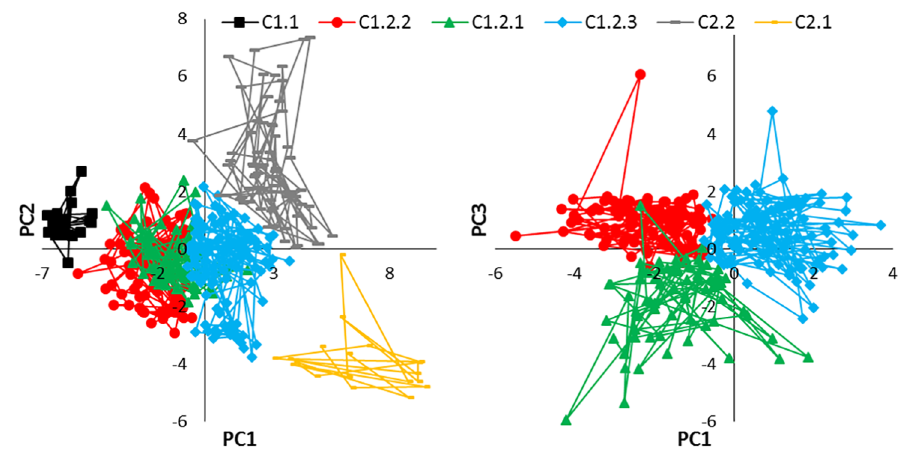
Fig. 5. On principal components planes constructed by PC1–PC2 and PC1–PC3 (and others not presented here), the cloud of the analysed samples grouped into clusters (C1.1, C1.2.1, etc.) demonstrates the correlation between samples and principal components. Note the different positioning of clusters on different planes, showing which component (and elements forming the corresponding component) best describe the samples in the cluster. On the plane PC1 (S, OM, trace metals) – PC2 (‘clay components’) clusters C1.2.1 (P 2 O 5 with SiO 2 , typical for the layers A and B1), C1.2.2 (Sr with CaO) and C1.2.3 (nearly corresponding to average oil shale) partially overlap, whereas on the plane PC1–PC3 (Sr and CaO with SiO 2 ) these clusters are located separately.